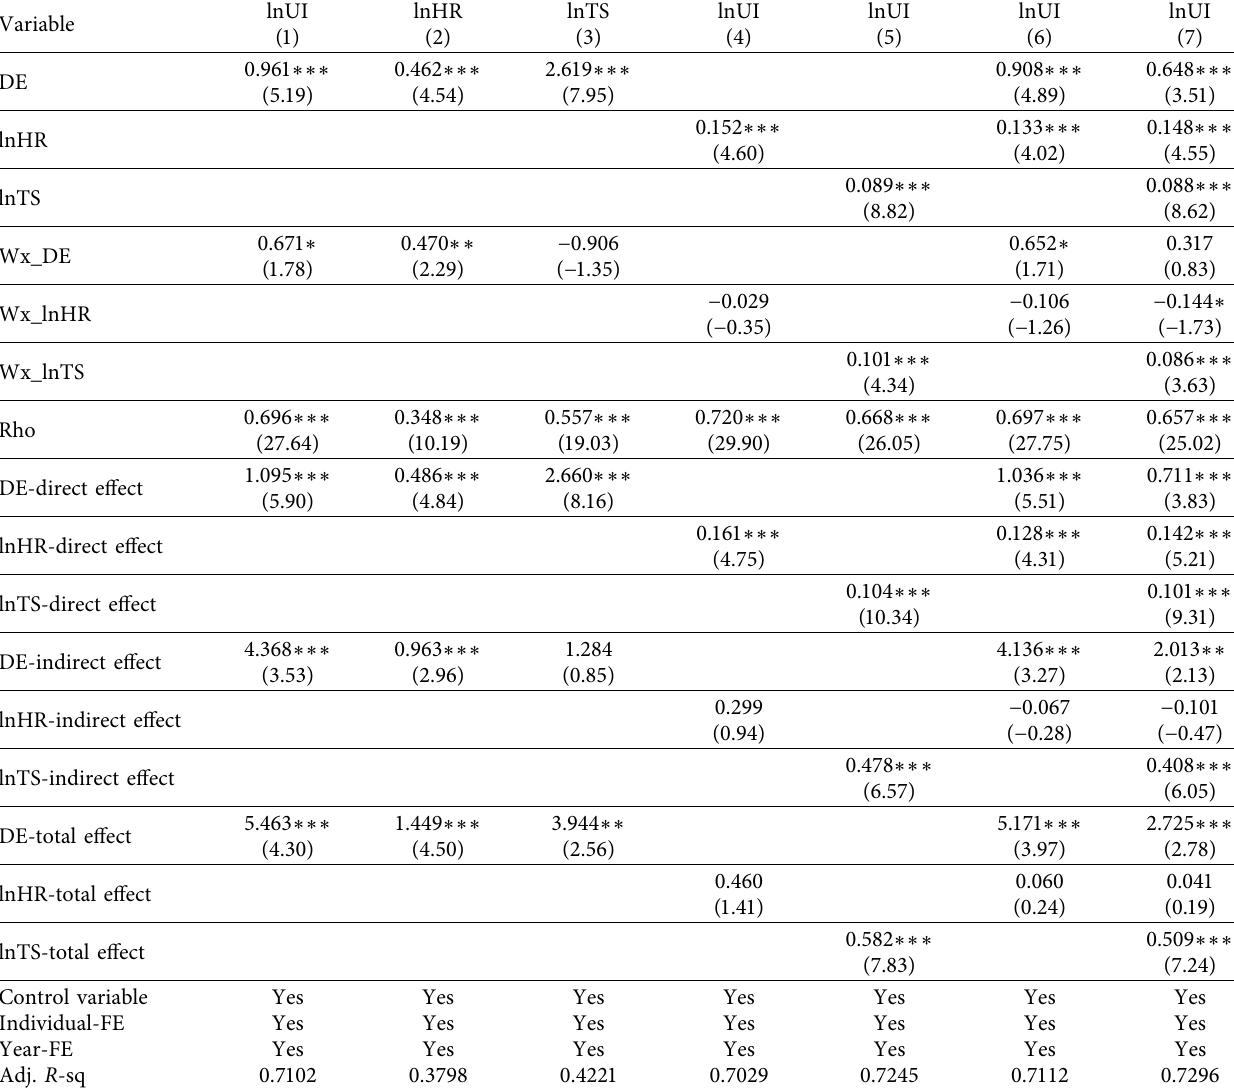
Table 8: Results of analysis of mechanisms of the digital economy to influence urban